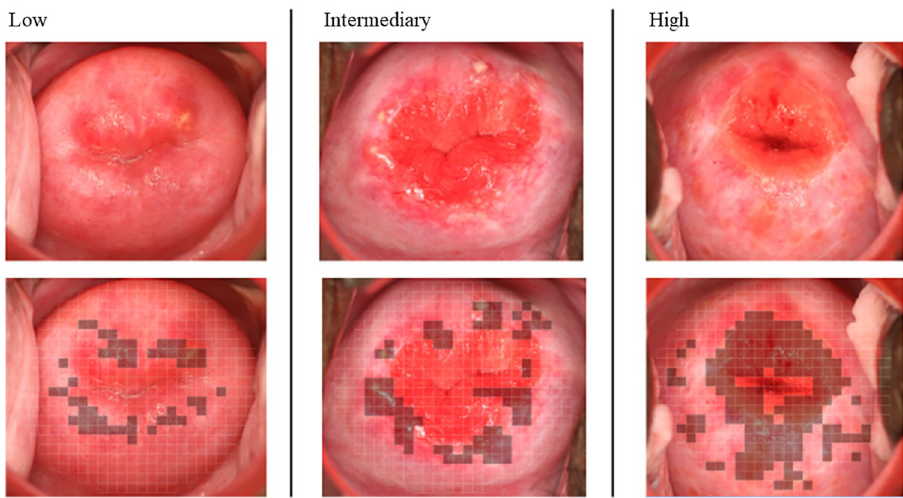
Fig 4. Three cases representing different levels of female genital schistosomiasis (FGS) associated pathology in accordance with the cervical lesion proportion (CLP) categories: low (1 to 15%), intermediary (16 to 30%), and high ( >